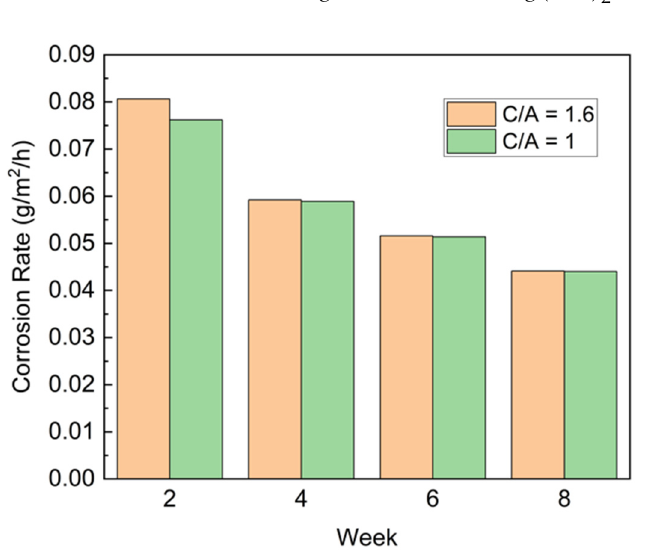
Figure 11. Corrosion rate in weight loss vs. cathode: anode area ratio index.